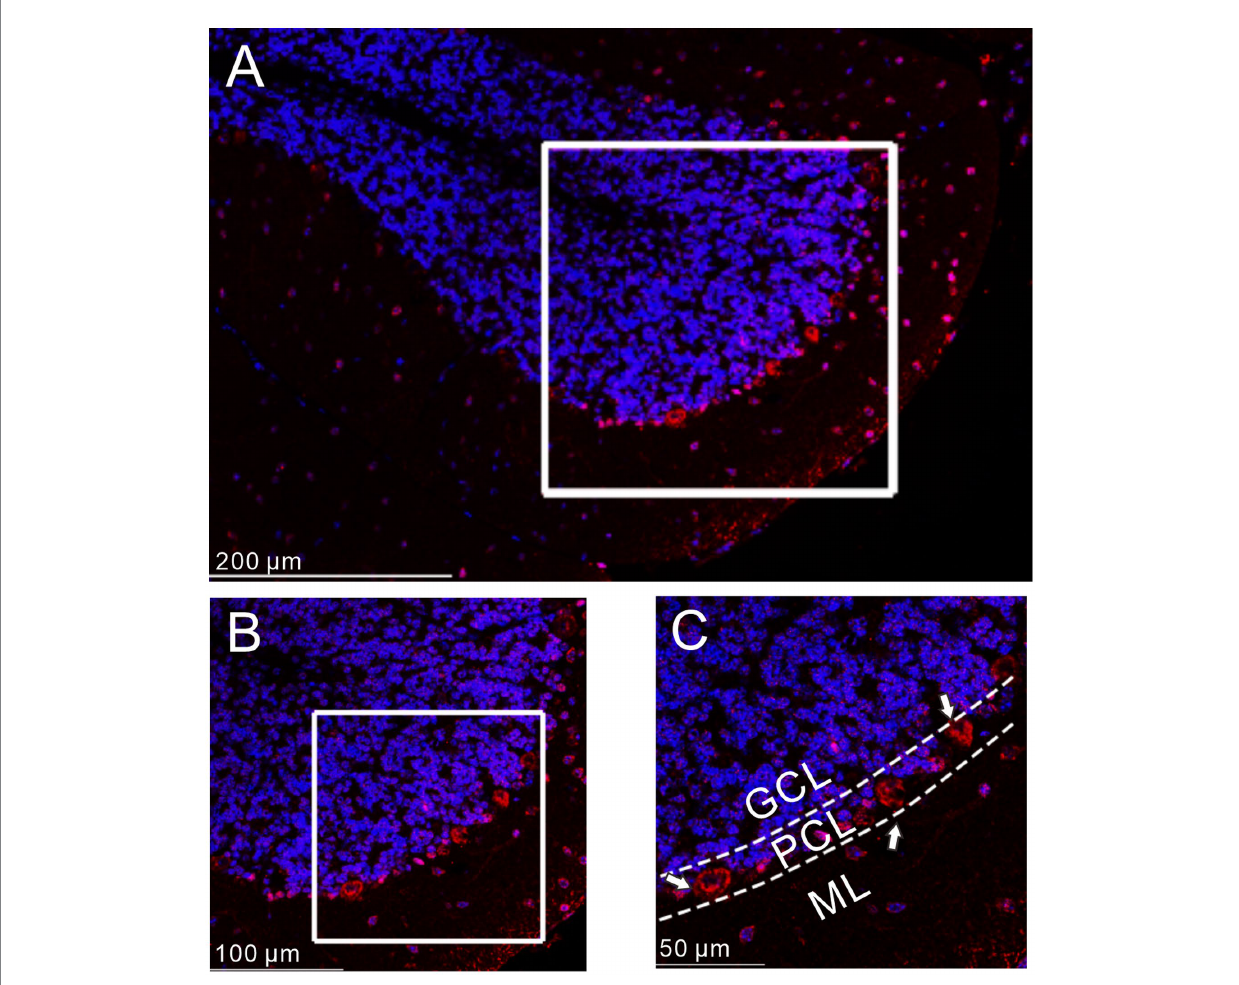
FIGURE 1 Immunofluorescence of GLP-1 receptor was expressed in cerebellar PCs. (A) A digital micrograph shows the confocal image of DAPI (blue) and GLP-1 receptor (red) in cerebellar cortex. DAPI (blue) was used for neuronal soma location. (B) Magnified image of the box area in (A) . (C) Enlarged image of the box area in (B) . The white arrows indicate the GLP-1 receptor expressed in the PCs. ML, molecular layer; PCL, Purkinje cell layer; GCL, granular cell